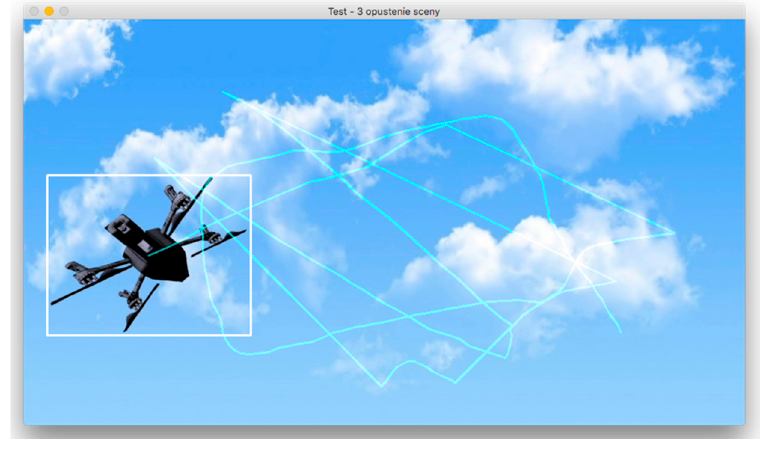
Figure 10. Leaving the sensing area.